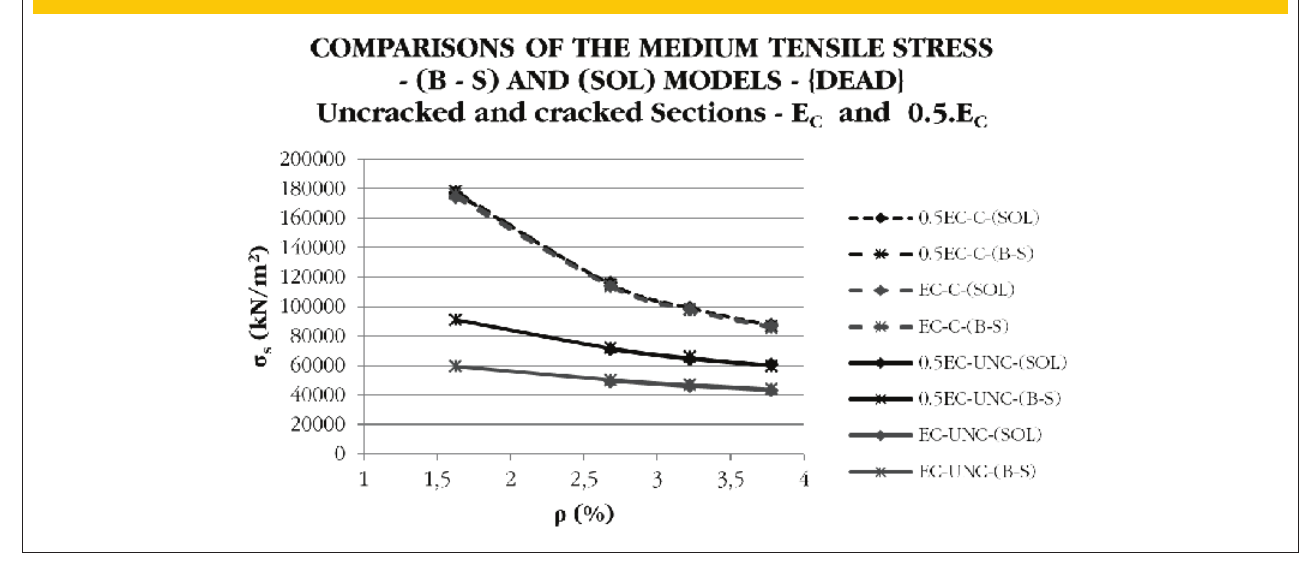
Figure 23 – Comparisons of the medium tensile stress in (B-S) and (SOL) models for {DEAD} load